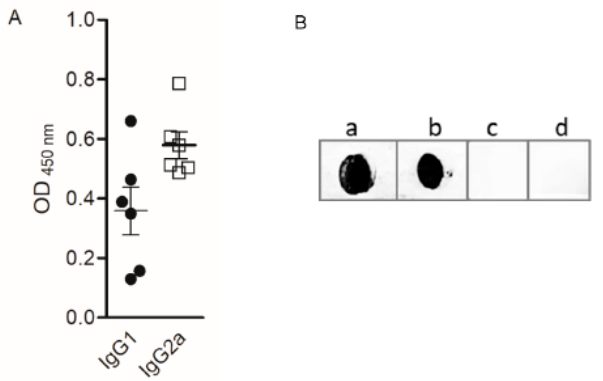
Figure 7. Reactivity of IgG antibodies induced by immunization of mice with DPx4. ( A ) Allergen-specific IgG1 and IgG2a levels by ELISA. ( B ) Sera from mice immunized with DPx4 were tested for IgG reactivity to dot-blotted D. pteronyssinus extract (a), DPx4 (b), and Bet v 1 (c). No reactivity was observed when blotted hybrid protein was incubated with pooled mouse pre- immune sera (d).